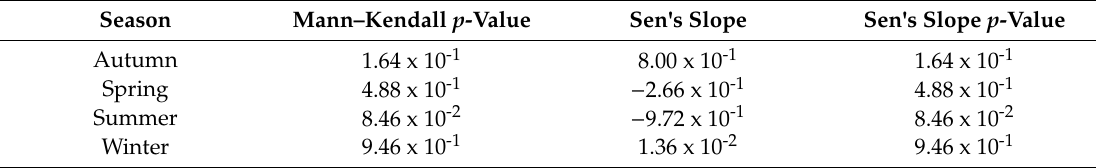
Table 4. Trend analysis of long-term precipitation data for the period 1951–2019. Parameters are the same as in Table